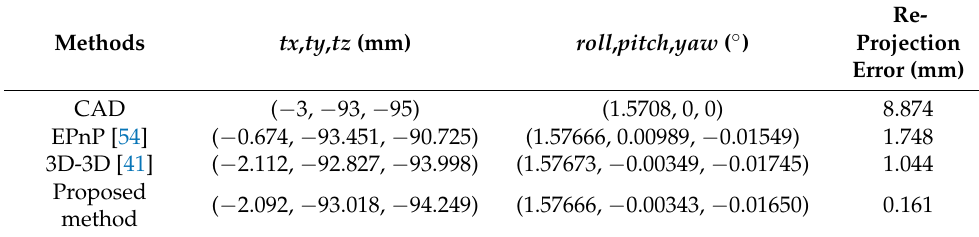
Table 4. Calibration results of RS-LIDAR-16 and ZED2-L. Table 3. Calibration results of RS-LIDAR-16 and MER-132-43GC-P.